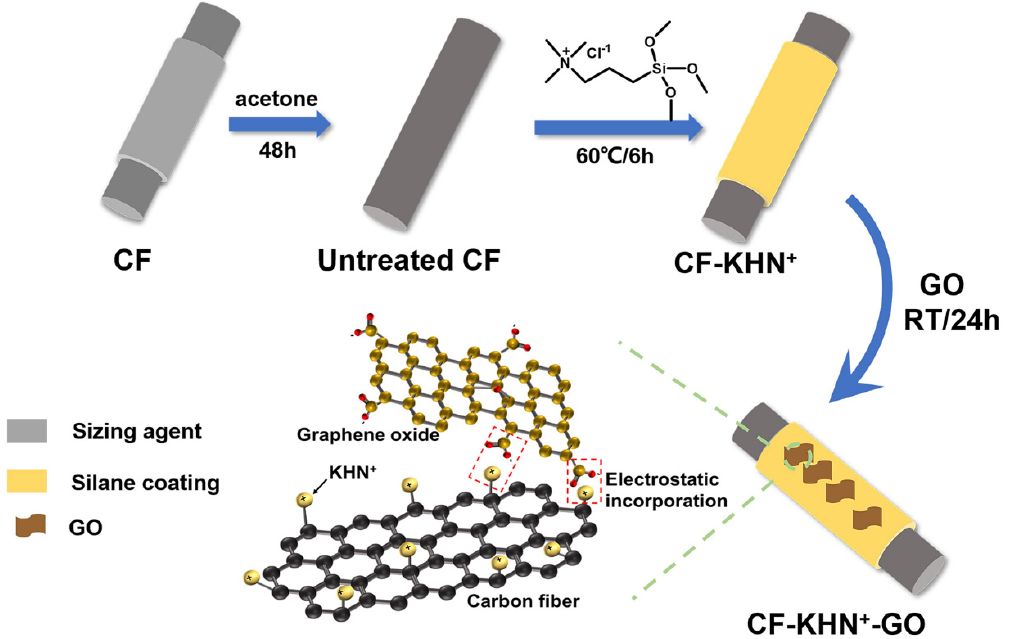
Figure 2. The schematic diagram of fabrication GO/CF multi-scale reinforcement.